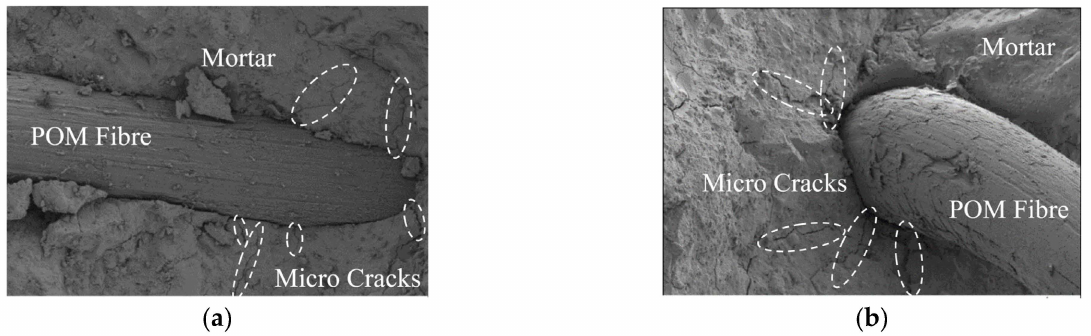
Figure 29. SEM results of POM0.6 SWSSC: ( a ) Along the fracture surface; ( b ) perpendicular to the fracture